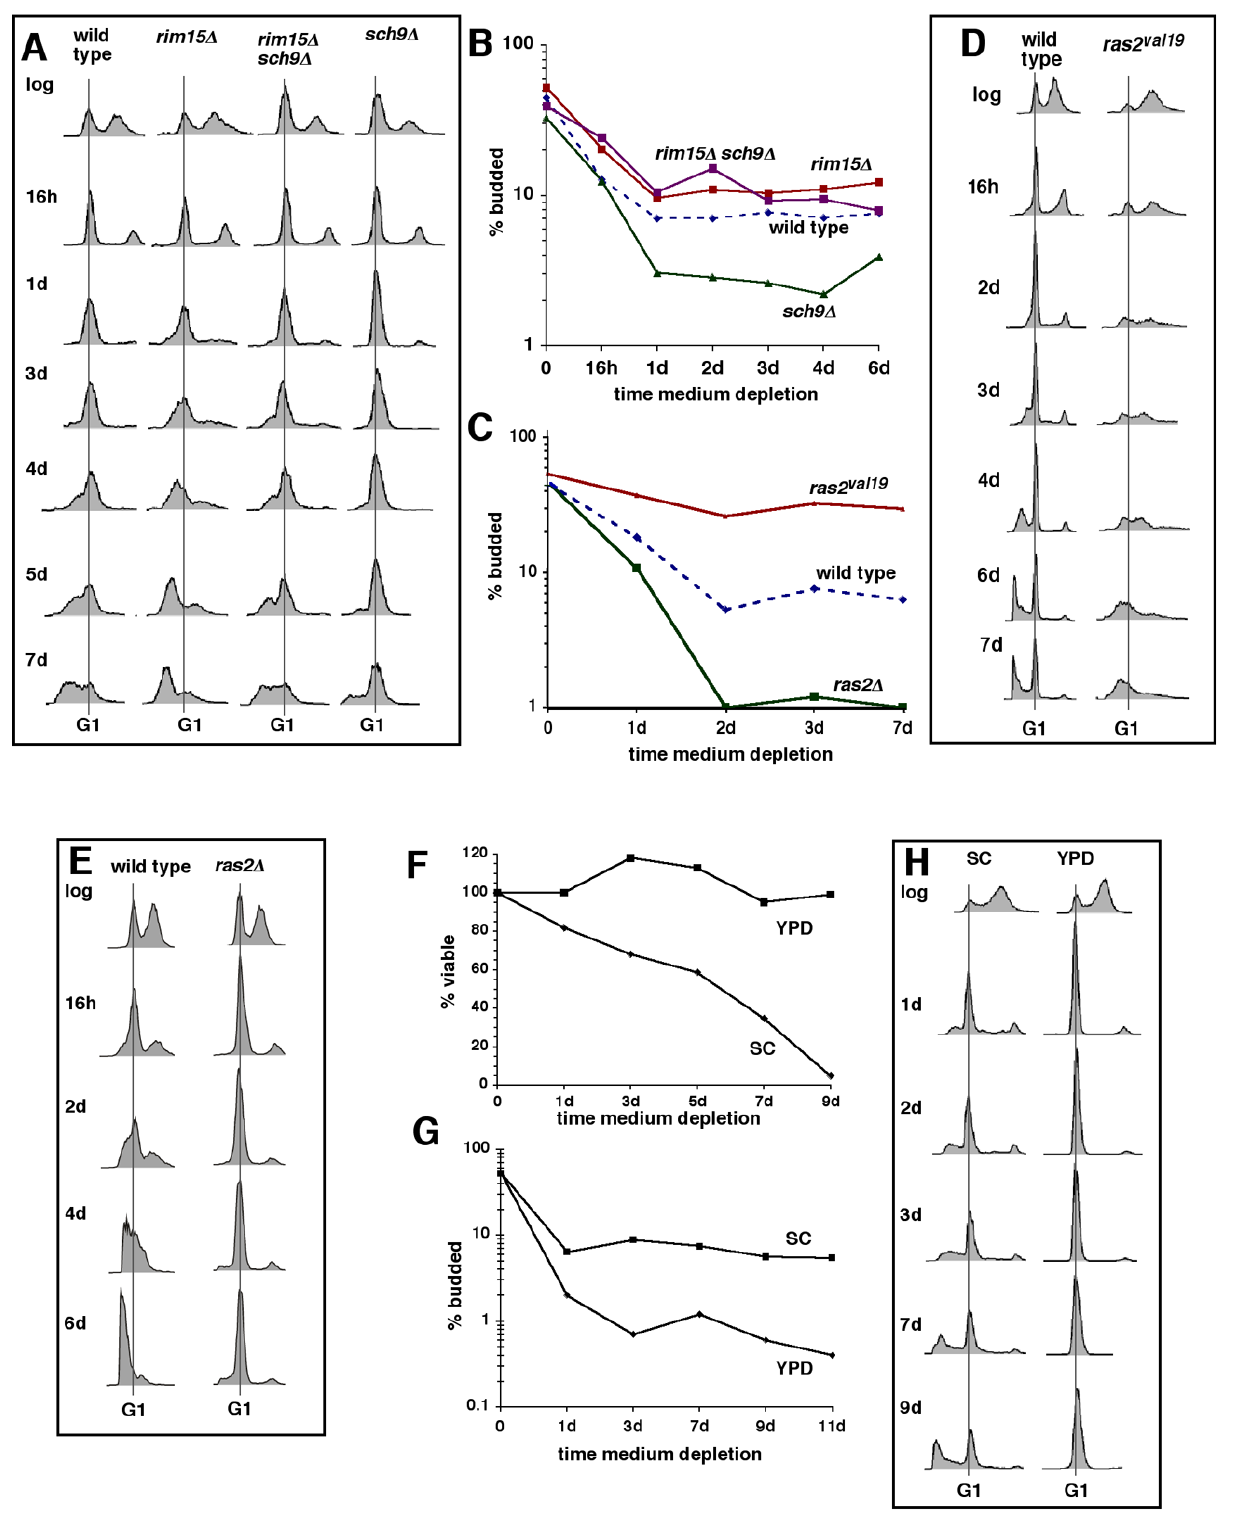
Figure 1. Chronological lifespan is related to the efficiency with which nutrient-depleted cells arrest in G1. A . Changes in DNA content during nutrient depletion of wild-type (DBY746) cells and cells harboring deletions of RIM15 and/or SCH9, which was previously shown to shorten ( rim15 D ) or lengthen ( sch9 D ) chronological lifespan [5]. Length of time cells were depleted of nutrients after establishing exponential cultures (‘‘log’’) is indicated to the left. B. Budding indices of cells in Panel A. C. Budding indices of wild-type cells and cells harboring the ras2 D or RAS2 val19 mutations. D. Changes in DNA content during nutrient depletion of wild-type cells and cells harboring the RAS2 val19 mutation. E. Changes in DNA content of wild type and ras2 D cells during nutrient depletion. F–H. Viability (F) , budding index (G) and DNA content (H) of wild-type cells nutrient depleted in synthetic complete medium (‘‘SC’’) or rich medium (‘‘YPD’’). Data in this and subsequent figures are representative of the data from three or more independent experiments unless noted otherwise. doi:10.1371/journal.pone.0000748.g001 PLoS ONE |